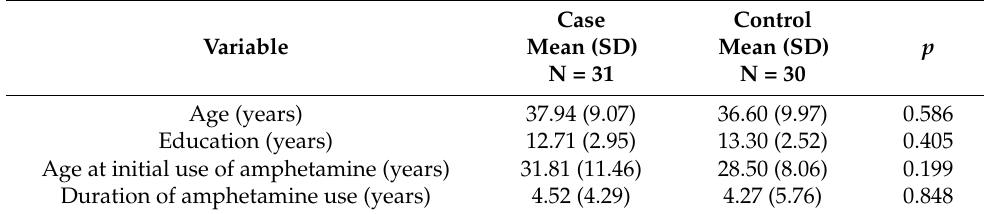
Table 1. Demographic and amphetamine-related characteristics of the case and control groups at study